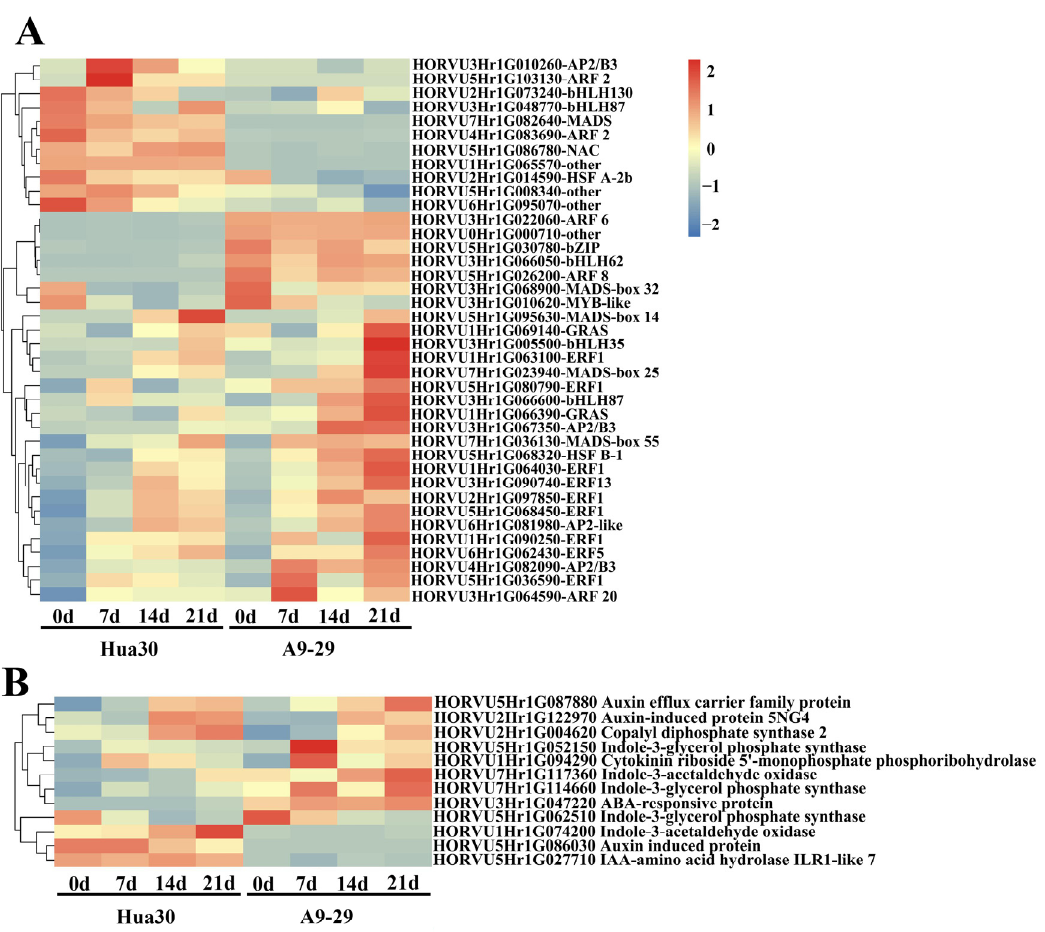
Figure 7. The average linkage hierarchical cluster analysis of DEGs encoding transcription factors ( A ). Hormone signaling-related DEGs ( B ).